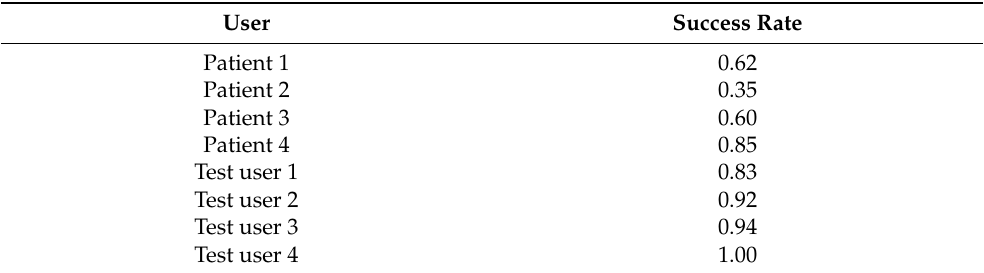
Table 2. The success rate for replaying sequences correctly during the Memory task for each patient. Patient 2 had the lowest success rate, while the success rate of patient 4 approached that of the non-clinical users.